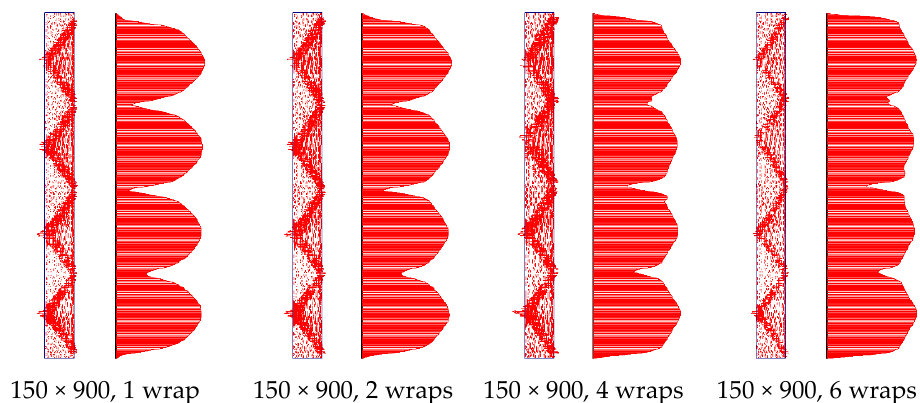
Figure 8. Half cross-section of the 150 mm × 900 mm cylinder with localized failure and the FRP wrap hoop strain profile at peak FRP strain = 1.5%.